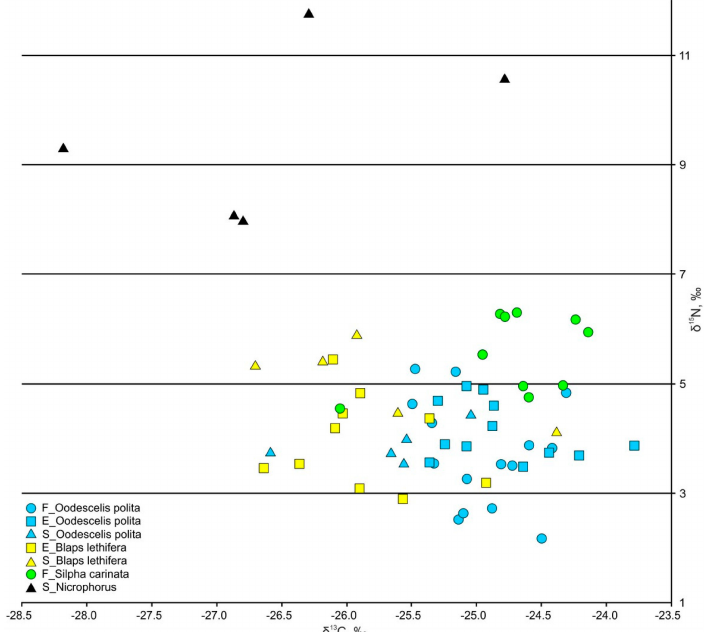
Figure A2. Distribution of saprophagous and necrophagous insects of the studied ecosystems in the δ 13 C– δ 15 N isotopic biplot. Each symbol shows one specimen. F: forest (circles), E: edge (squares), S: steppe